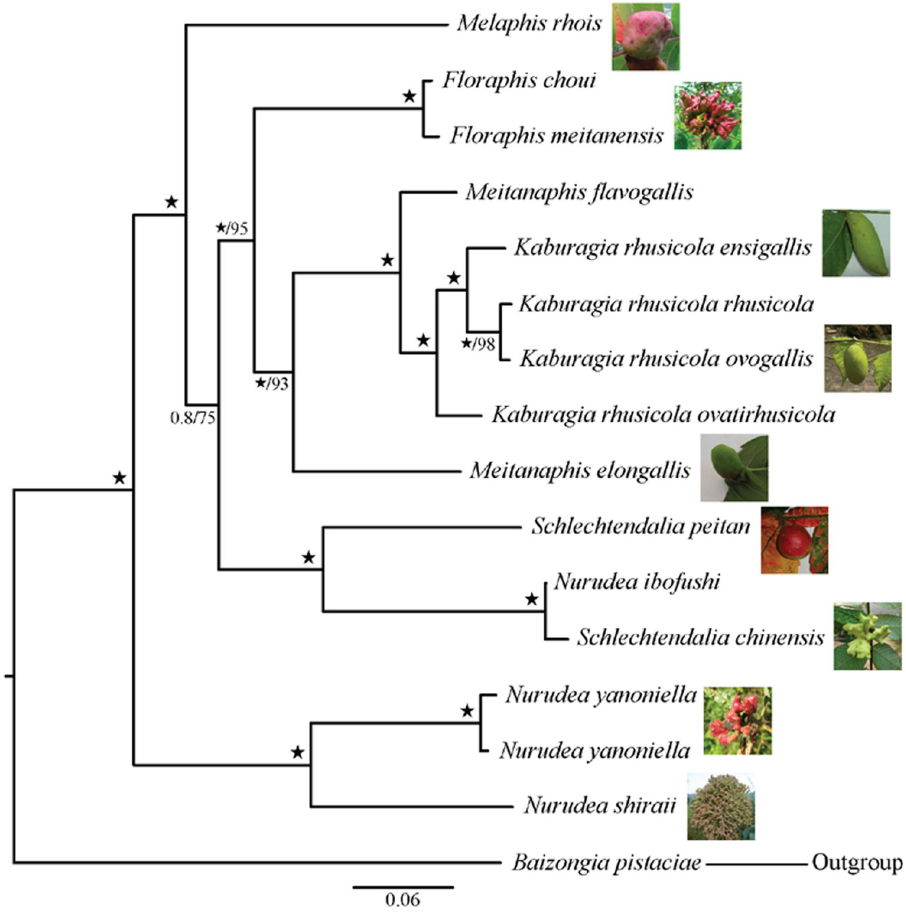
Fig 1. Bayesian 50% majority-rule consensus tree of the Melaphidina aphids based on the combined dataset of 15 mitochondrial and five nuclear gene sequences. Numbers on the branches show the Bayesian posterior probabilities (PP, left) and bootstrap values from maximum likelihood (BS, right) analyses. Stars represent nodes with 1.00 PP and 100% BS.